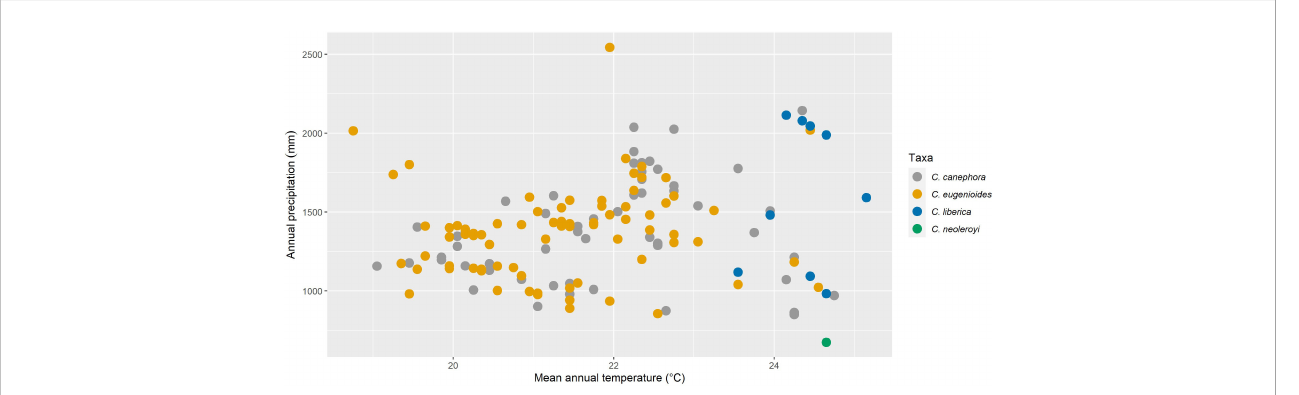
FIGURE 2 Scatter plots of modelled annual mean temperature (CHELSA Bio1) vs. total mean annual precipitation (CHELSA Bio12) for four indigenous Ugandan Coffea species (mean values in parentheses): C. canephora (21.8°C/1,389 mm); C. eugenioides (21.3°C/1,370 mm); C. liberica var. dewevrei (24.4°C/1,560 mm); and C. neoleroyi (data not available).